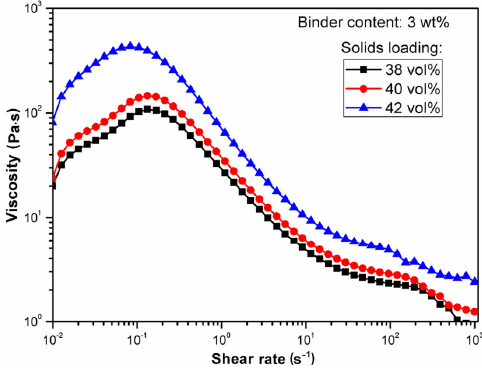
Fig. 4 Viscosity of AlN slurries with different solids loading (PIBM addition: 3 wt%).